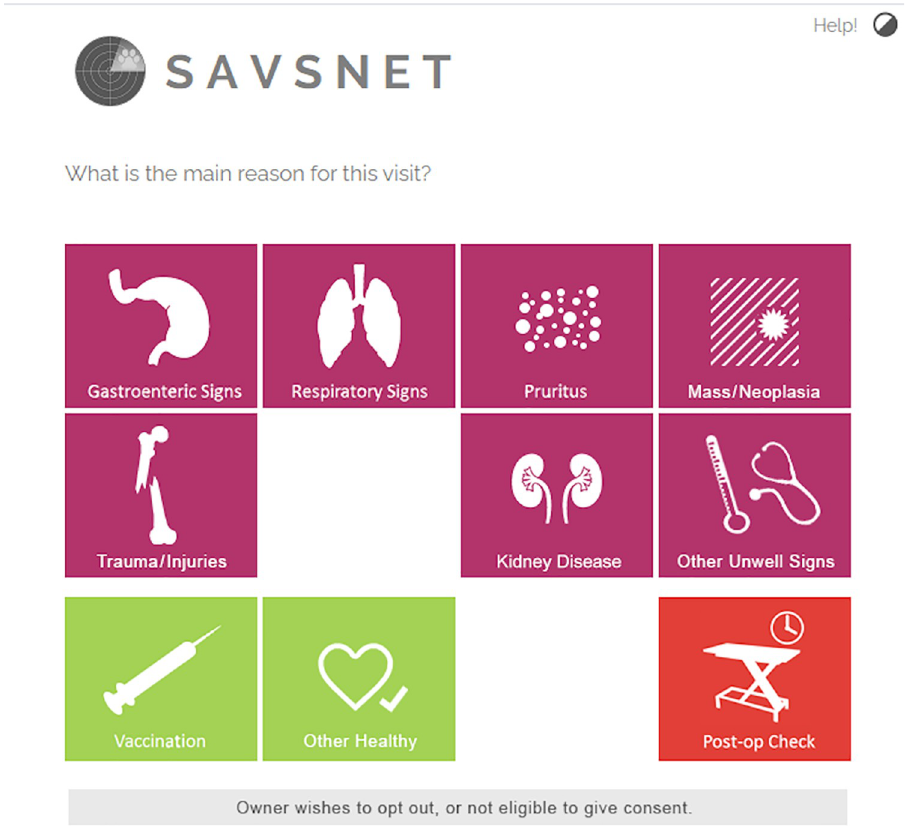
Fig 1. SAVSNET MPC window. At the end of each consultation, veterinary clinicians are required to annotate the health record selecting from a list of syndromes or main presenting complaints (MPCs) as shown.